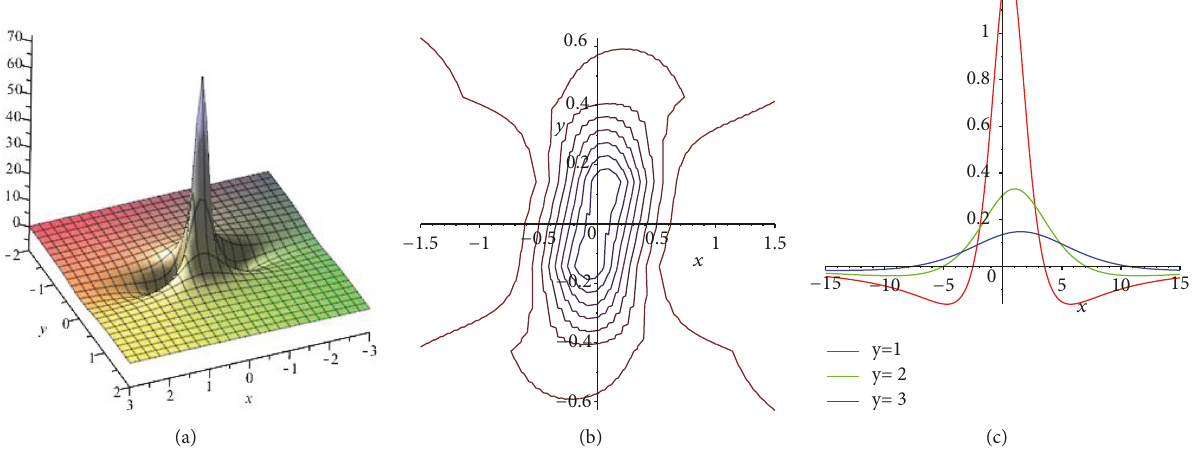
Figure 2: Plots of lump solution in Case 2 with 𝑎 1 = 1 , 𝑎 2 = −1/2 , 𝑎 4 = 0 , 𝑎 5 = 0 , 𝑎 6 = 3 , 𝑎 8 = 0 at 𝑡 = 0 : (a) 3D plot, (b) density plot, and (c)